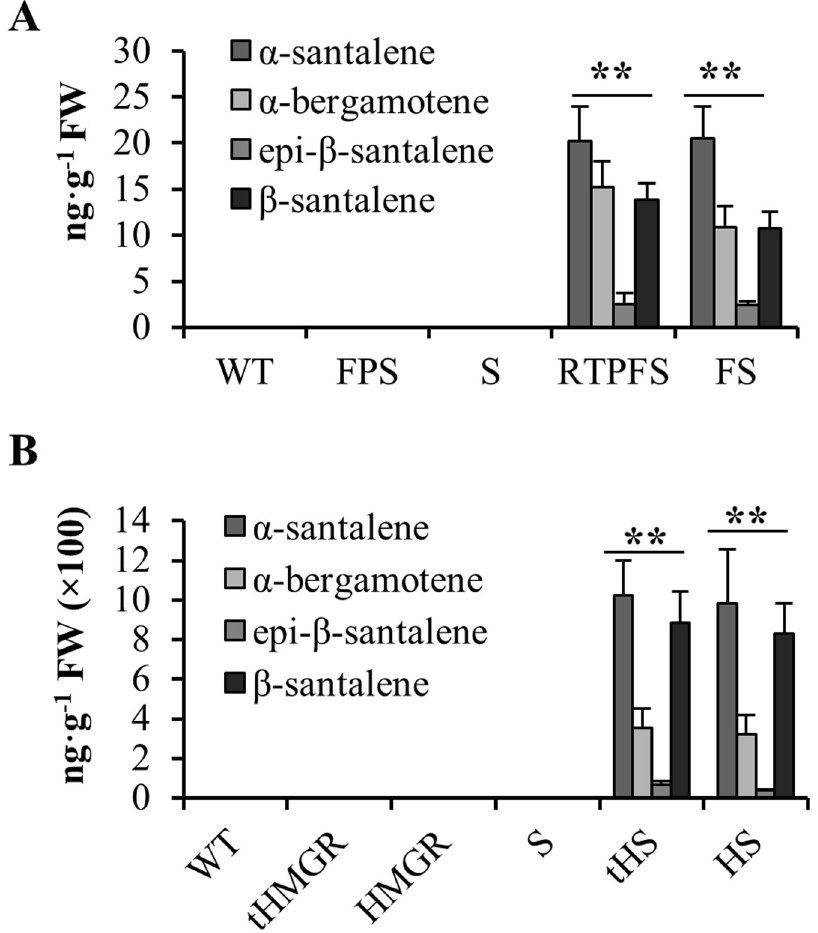
Fig 2. Chloroplast targeting and MVA enhancement strategies enhance the production of santalenes and bergamotene in Nicotiana benthamiana agro-infiltrated leaves. (A) The production of santalenes and bergamotene in N . benthamiana transiently expressing RTP - FPS + RTP - SaSSy or FPS + SaSSy ; (B) The production of santalenes and bergamotene in N . benthamiana transiently expressing tHMGR + SaSSy or HMGR + SaSSy . RTP, Arabidopsis thaliana ribulose bisphosphate carboxylase small subunit transit peptide; SaSSy, Santalum album santalene synthase; FPS, A . thaliana farnesyl diphosphate synthase; HMGR, A . thaliana 3-hydroxy-3-methylglutaryl-CoA reductase; tHMGR, A . thaliana truncated HMGR; WT, wild type; S, lines expressing SaSSy ; FS, lines transiently expressing FPS + SaSSy ; RTPFS, lines transiently expressing RTP - FPS + RTP - SaSSy ; tHS, lines transiently expressing tHMGR + SaSSy ; HS, lines transiently expressing HMGR + SaSSy . The mean ± SD values of three biological replicates are shown. Asterisks indicate statistically significant differences of total santalenes and bergamotene from S based on Student’s unequal variance t 0 -test ( � P < 0.05 and �� P <